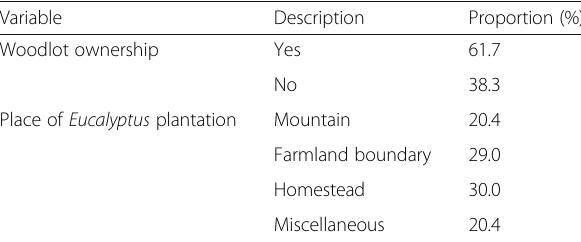
Table 2 Woodlot ownership and place of Eucalyptus plantation in Gudo Beret Kebele